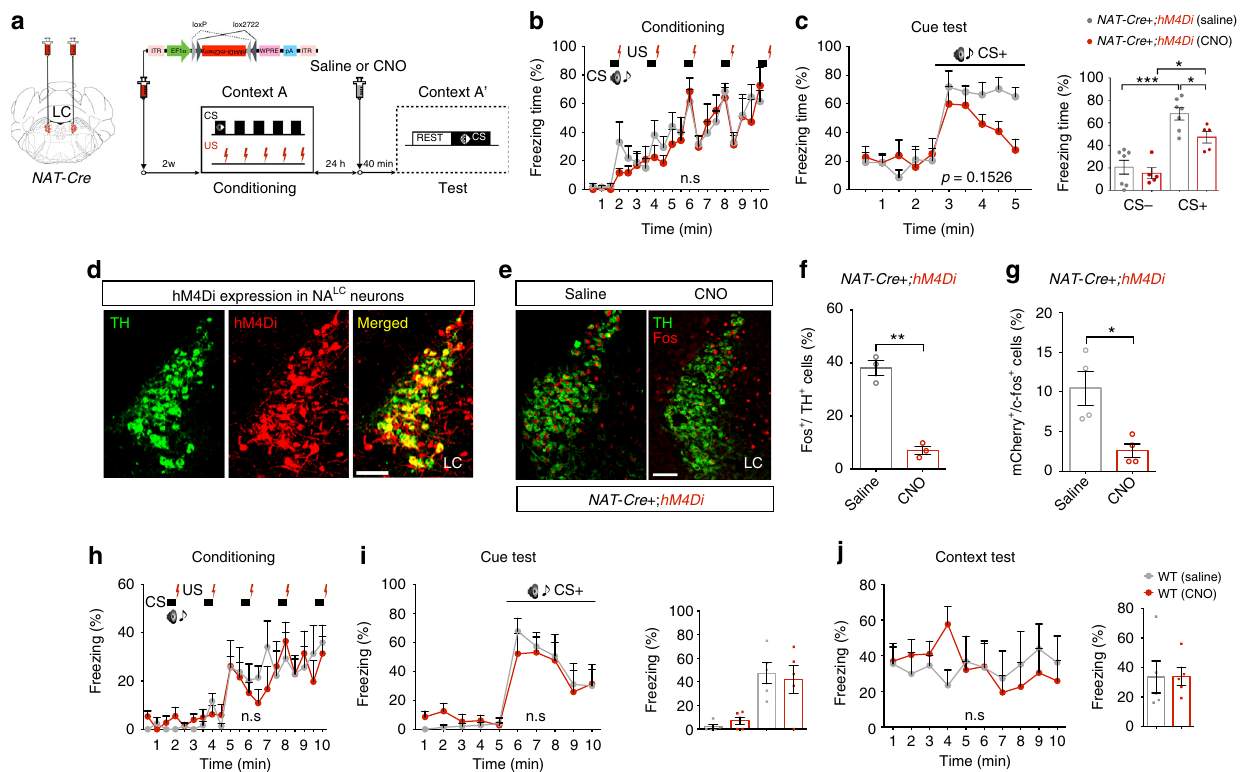
Fig. 2 Pharmacogenetic inhibition of NA LC neurons decreased cue-induced freezing behavior. a Experimental protocol. b , c After cued fear conditioning, CNO (clozapine-N-oxide) administration 40 min before the test session decreased freezing behavior against a conditioned stimulus (CS) in test session. d Images showing that AAV-mediated hM4Di-mCherry (red) expression is especially observed in TH-positive NA LC neurons (green) of NAT-Cre mice. Scale bar, 100 μ m. e Images showing Fos/TH-double-labeled cells in the LC after test session in saline- or CNO-treated mice. Scale bar, 100 μ m. f Percentage of Fos + /TH + cells in the LC. g Percentage of Fos + /mCherry + cells in the LC. h – j After cued fear conditioning, CNO does not affect cued and contextual fear expression in wild-type mice. * p < 0.05, ** p < 0.01, *** p < 0.001. Values are mean ±